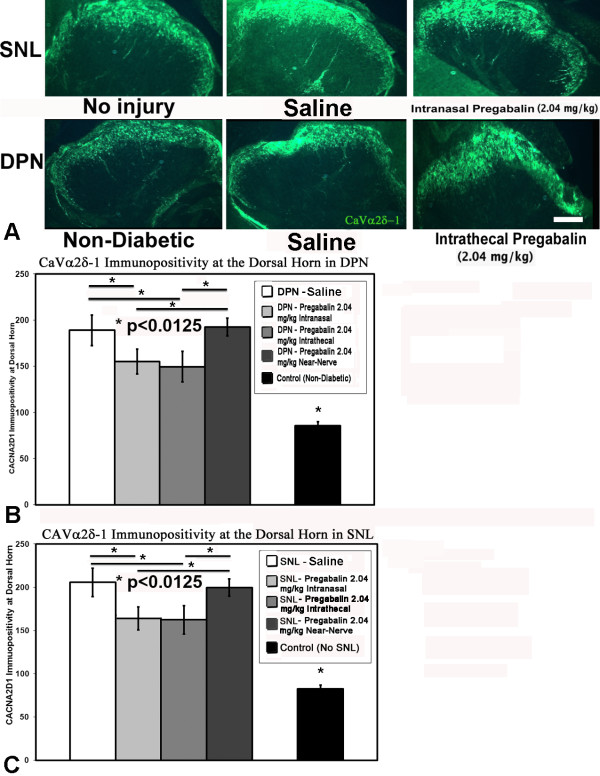
CaVα2δ-1 protein expression. CaVα2δ-1 protein expression was detected by immunohistochemistry at the dorsal horn regions of rats subjected to spinal nerve ligation or diabetes (A). Rats exposed to high dose (2.04 mg/kg/d) pregabalin provided intrathecally or intranasally had less expression of CaVα2δ-1 at the dorsal horn as compared to rats receiving near-nerve delivery of pregabalin or with saline delivery for both models of diabetic peripheral neuropathy (DPN) (B) and spinal nerve ligation (SNL) (C). As compared to control rat specimens, the presence of either spinal nerve ligation or diabetes uniformly led to upregulation of CaVα2δ-1 at the dorsal horn. Unmatched ANOVA tests were performed between cohorts receiving pregabalin and saline for each intervention and condition, and between intervention locations, with * indicating significant difference (p < 0.0125 after Bonferroni corrections) between cohorts [n = 3-5 specimens for each cohort].